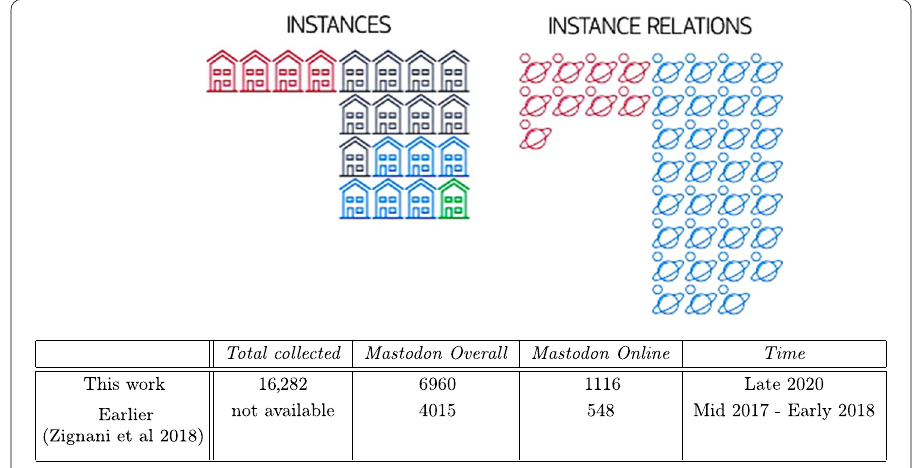
Fig. 1 Validated data based on the information reported in Table 1, and illustrative comparison between dimensions of the earlier state-of-the-art (in red) and dimensions of our